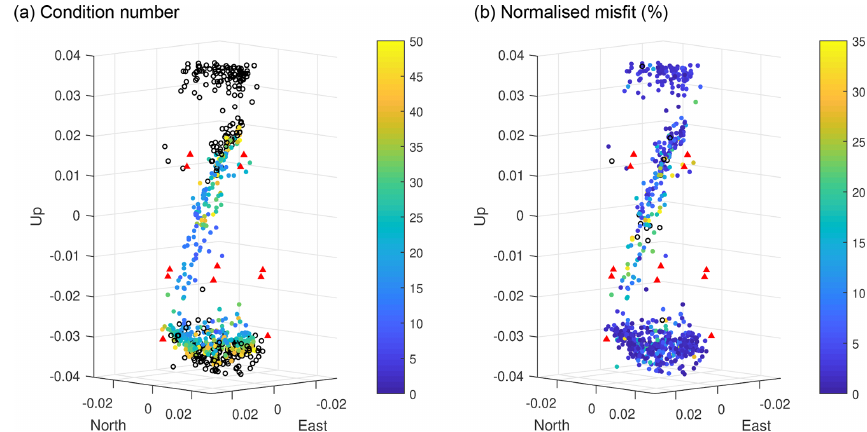
Figure 5. Filtering of the 795 inferred moment tensors for biaxial decomposition, resulting in a subset of 418 events. (a) Condition number of moment tensor inversion: events with a condition number of 50 and below (in colour) were kept, and 50 and above (black circles) were excluded from further analysis. (b) Normalised misfit of moment tensor inversion: events with a misfit of 35% and above were also excluded.